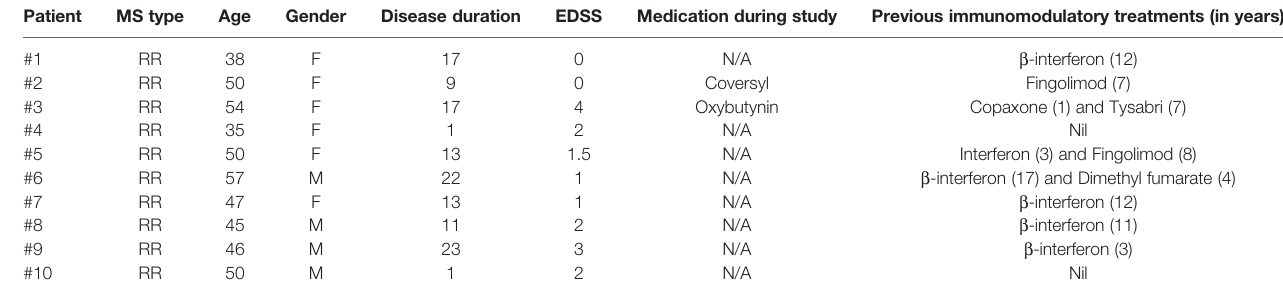
TABLE 1 | Summary of MS patients ’ clinical